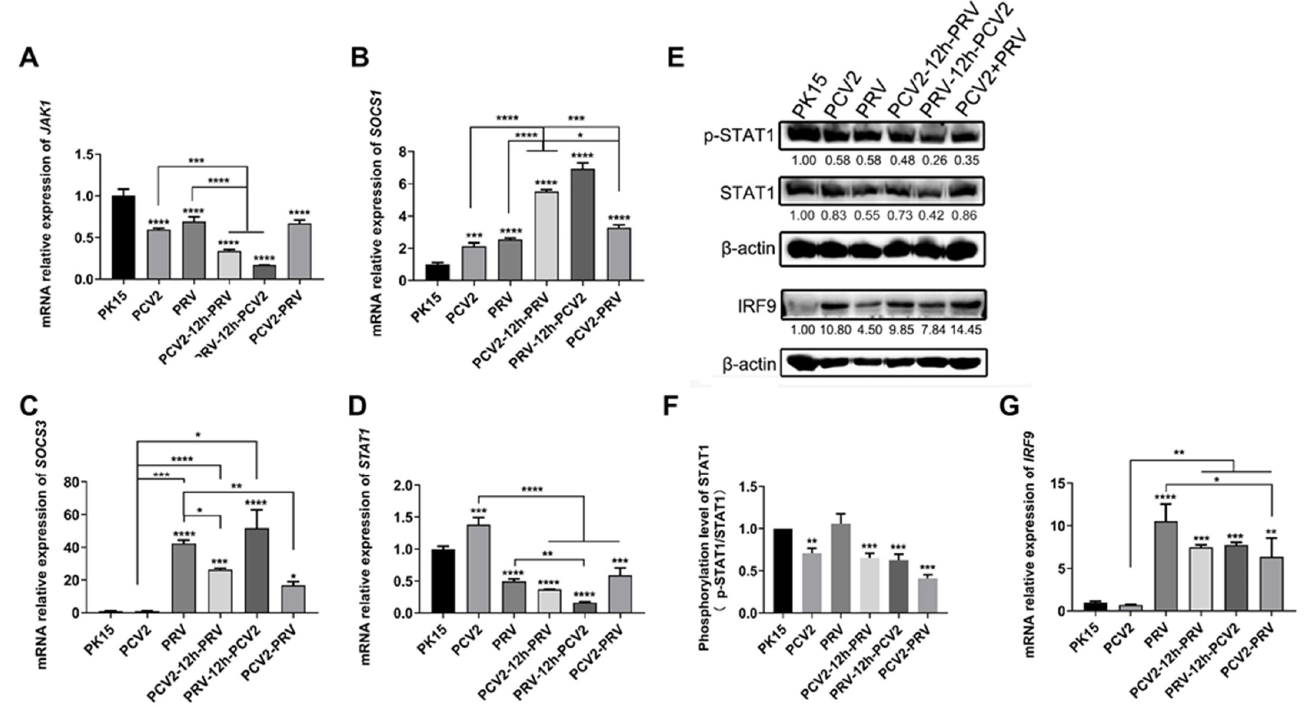
Figure 4. Coinfection of PCV2 and PRV suppresses STAT1-related JAK/STAT pathways. ( A – D ) Expression levels of JAK/STATs. The relative mRNA levels of JAK1 ( A ), SOCS1 ( B ), SOCS3 ( C ), and STAT1 ( D ) were detected using real-time PCR. ( E , F ) Protein levels of STAT1 and IRF9. Western blotting was performed using p-STAT1, Anti-STAT1 Antibody, IRF9 Antibody, and Anti- β -Actin Antibody as primary antibodies, respectively. HRP-labeled Goat Anti-mouse IgG (H+L) and HRP- labeled Goat Anti-rabbit IgG (H+L) were used as the secondary antibody. β -actin was used as a control. The average expression level of the target protein in each group is shown below each lane. The protein amount of the PK-15 group is set to 1, and the values of other groups are the ratio with the PK-15 group. ( G ) Expression levels of IRF9 were detected using real-time PCR. The data are presented as the means ± SD. *, p -value < 0.05; **, p -value < 0.01; ***, p -value < 0.001; ****, p -value < 0.0001. Unprocessed original images can be found in Supplementary Figure S3.